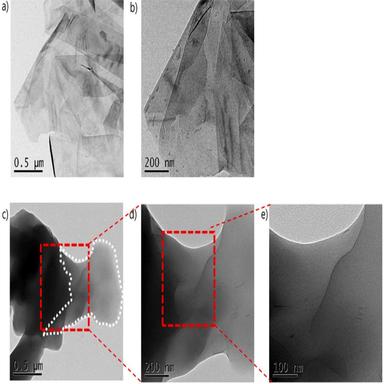
TEM micrographs of pristine GNP-M25 (a, b) and abraded Epoxy/1.0 wt% GNP-M25 powder (c-e).